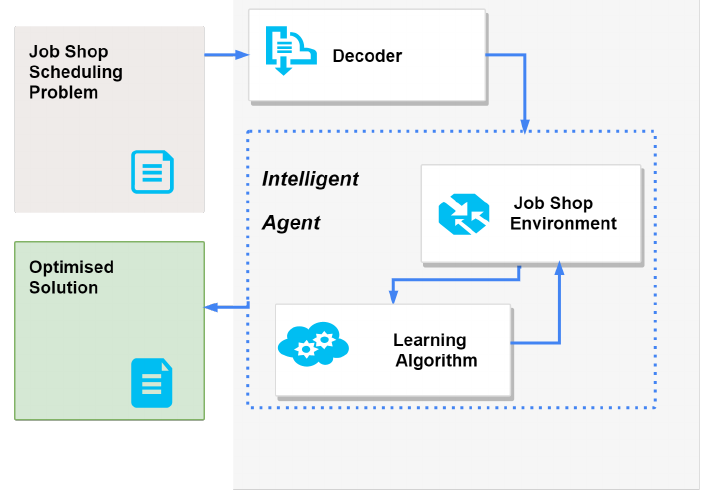
Figure 3. Diagram of the developed system (adapted from our previous proposal